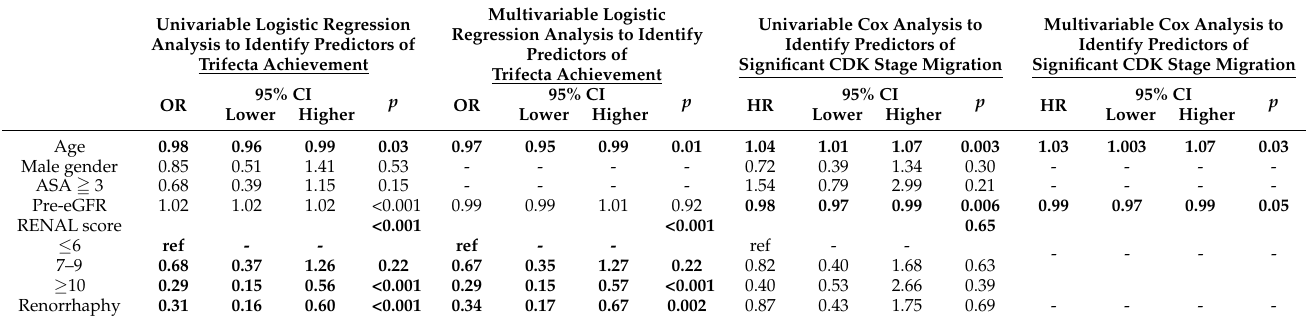
Figure 1. Impact of renorrhaphy on significant CKD stage migration-free survival (SMFS) probabili- ties after ocRPN. Table 2. Uni-/multivariable logistic regression analyses to identify predictors of trifecta nonachieve- ment and Cox analyses to identify predictors of significant CKD stage